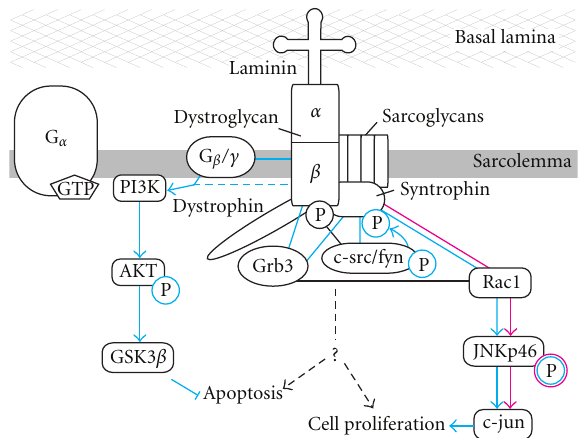
Figure 2: The dystrophin-glycoprotein complex may participate in laminin-dependent signaling in skeletal muscle. Interactions shown in blue indicate interactions that have been shown to be increased when laminin is bound to dystroglycan. Interactions in pink indicate those that have been shown to be increased following a muscle contraction protocol. Since the phosphorylation of β -dystroglycan can bind a number of other SH2-domain containing proteins and can also interact with Grb2, it may participate in additional signal transduction cascades that have not yet been identified. It is important to remember that in many cases, these interactions have been studied in cell culture systems and the relevance of these interactions in muscle in vivo has not been extensively